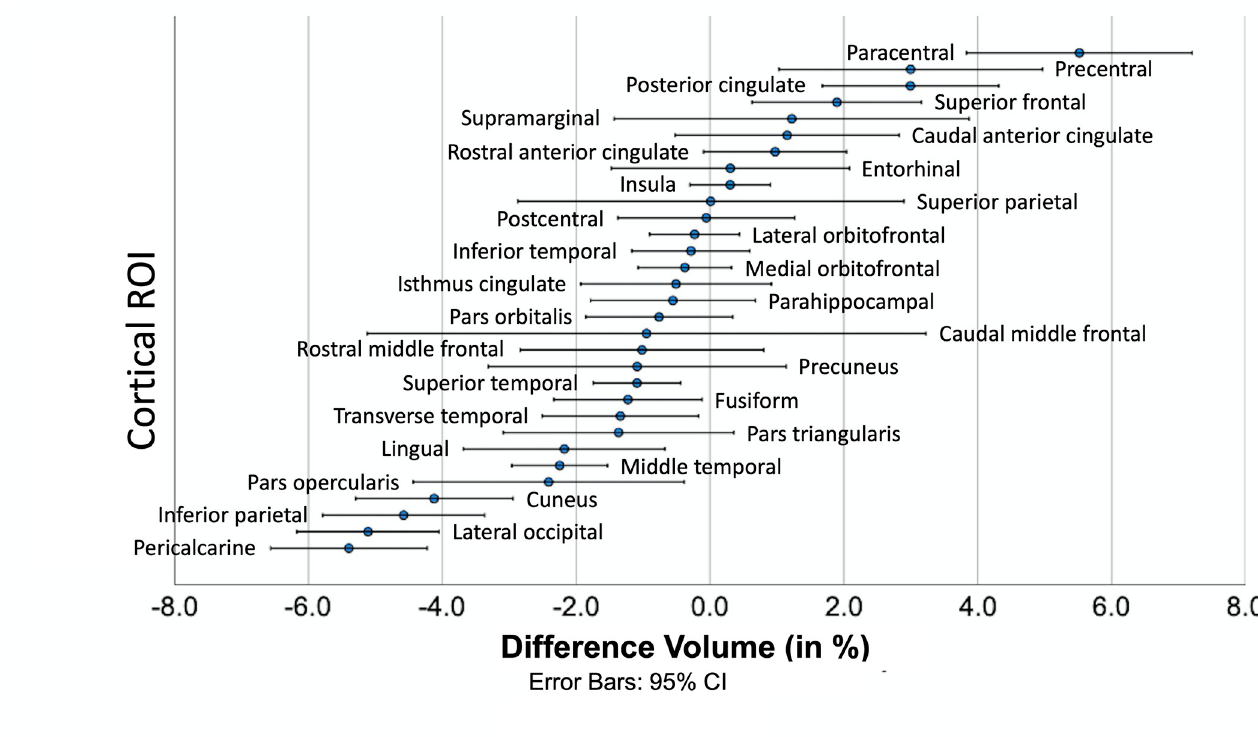
Fig 4. Mean differences of volume for each ROI between nDC and DC data. The ROIs (y axis) are sorted by their mean percentage differences. The dot indicates the mean and the error bars indicate the 95% confidence interval.